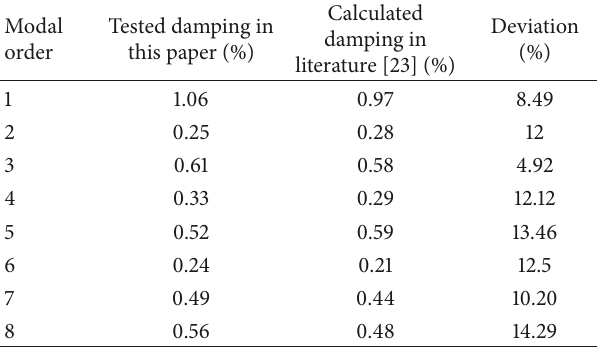
Table 5: The tested damping obtained experimentally in this paper and the calculated damping obtained in the literature and their